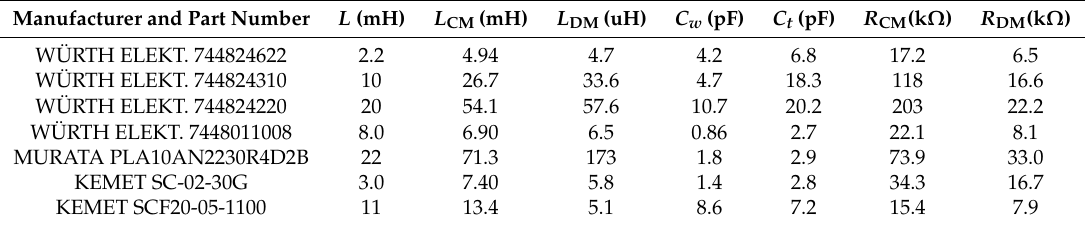
Table 2. Parameters extracted for the equivalent circuit of Figure 1b for several commercial common mode